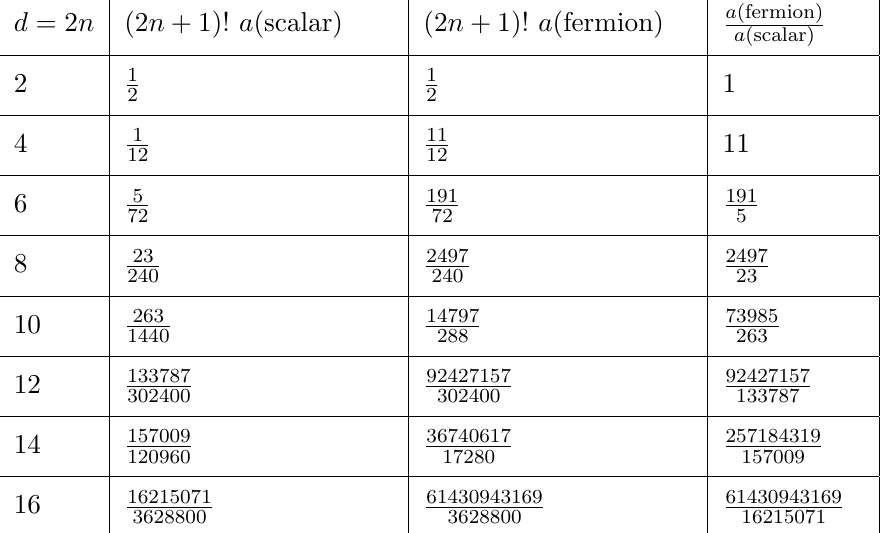
sigma model can be traded with a purely bosonic linear sigma model and the curvature e(cid:11)ects are taken care of by a suitable e(cid:11)ective scalar potential, which extends the